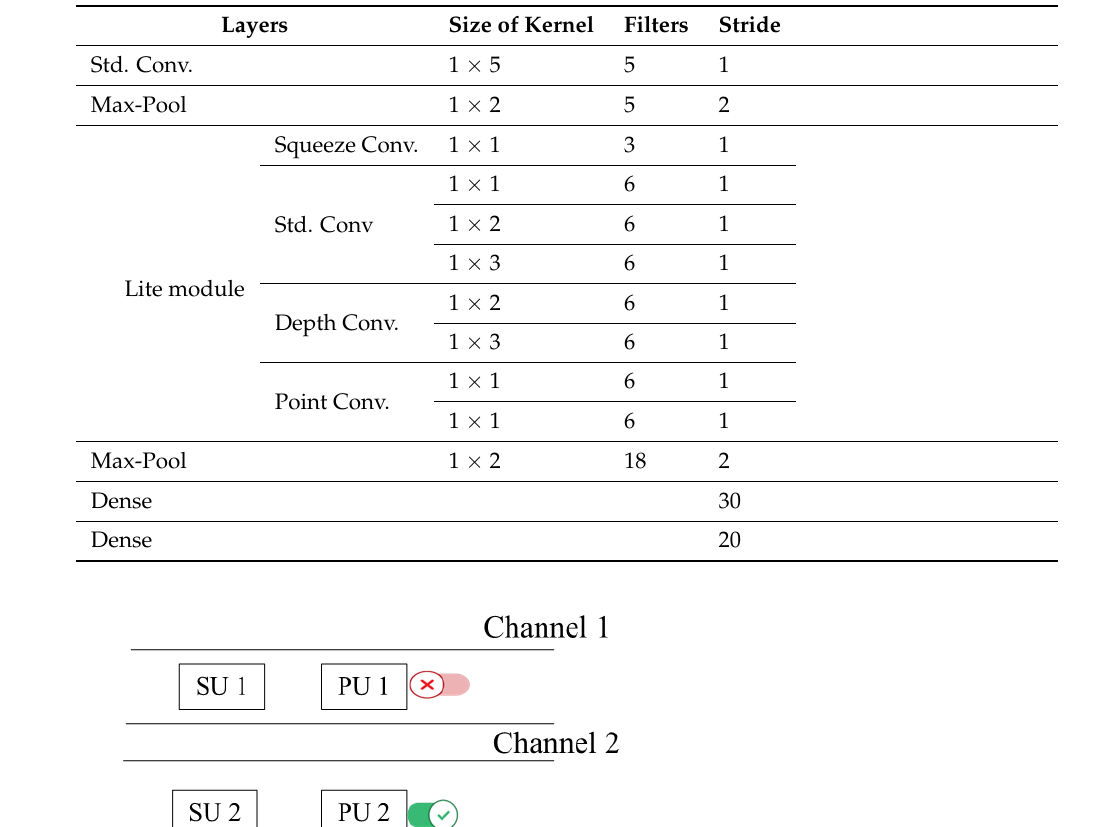
Table 3. Structure of Lite-CNN.